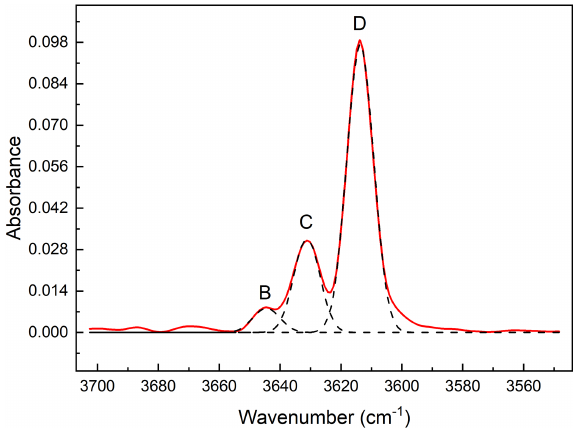
Figure 8. The OH-stretching FT-IR spectrum (red line) of ferro- ferri-holmquistite resolved into Gaussian components (broken lines). Three peaks can be identified in the spectrum, centered at 3614, 3631 and 3644cm − 1 from right to